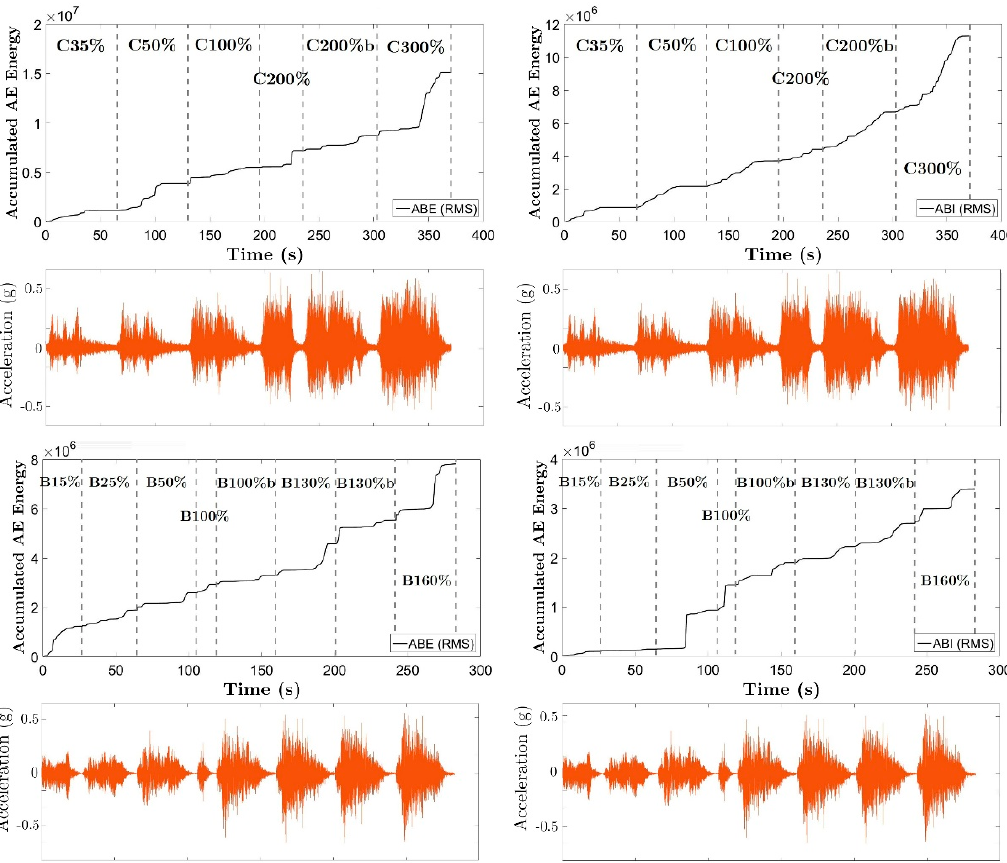
Figure 9. The accumulated AE energy in the ESH and ISH zones for BS1 (top) and BS2 (bottom) specimens. Bottom of the figures: Ground acceleration as a function of time.